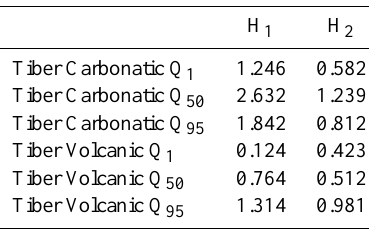
Table 6. Results of the Hosking and Wallis (1997) homogeneity tests for annual maxima Q 1 , mean values Q 50 and annual minima Q 95 for the two Tiber River regions.